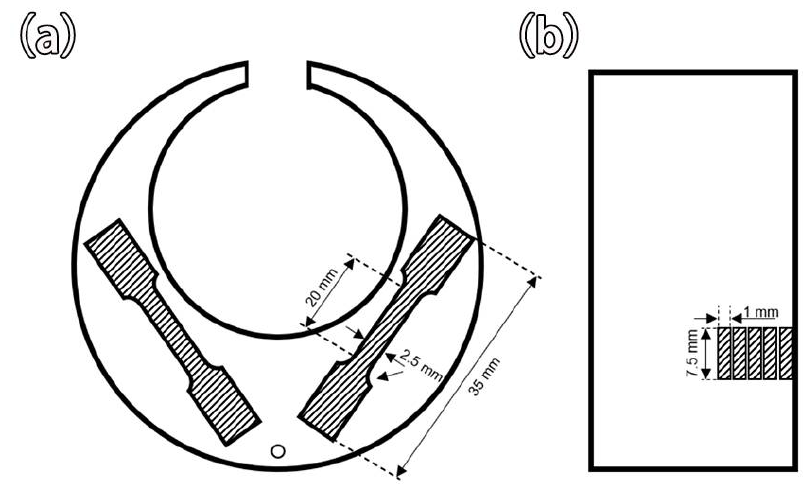
Figure 2. The mini-tensile specimens were fabricated out of the heat-treated C-rings’ core: ( a ) vertical sampling position; ( b ) specimen thickness and sampling distance from carburizing surface depth.